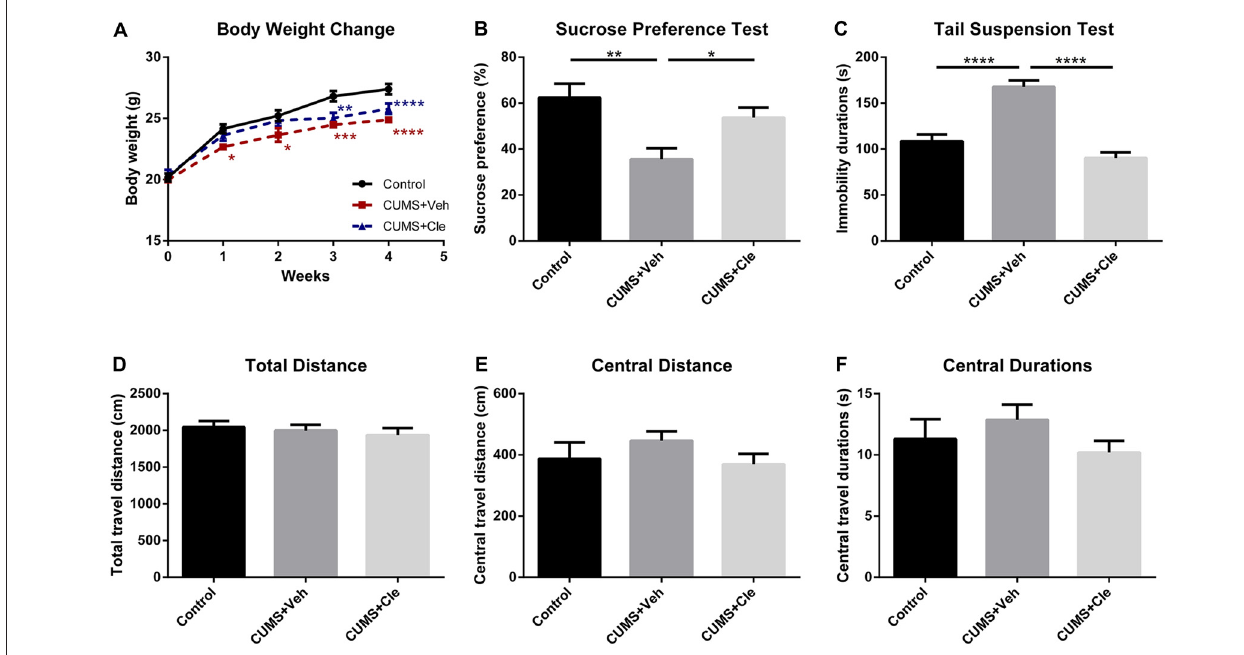
FIGURE 2 | Body weight change throughout the stress procedure and behavioral analyses after the 4-week treatment. (A) From the first week of stress regimen, mice in CUMS + Veh group maintained less body weight than that of Control, whereas CUMS + Cle group did not show such a trend until the third week ( ∗ p < 0.05, ∗∗ p < 0.01, ∗∗∗ p < 0.001, ∗∗∗∗ p < 0.0001 vs. Control). (B) At the end of week 4, lower sucrose preference ratio was detected in CUMS + Veh group ( ∗ p < 0.05, ∗∗ p < 0.01). (C) In Tail Suspension Test (TST), immobility durations of CUMS + Veh group were longer than that of the other groups ( ∗∗∗∗ p < 0.0001). (D–F) As for analysis in locomotor activity, there is no significant difference among the three groups on all the displayed aspects ( n = 10 for A–F ).